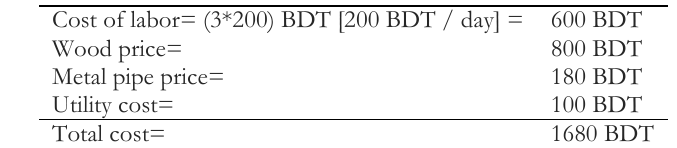
Table 7. Cost estimation for the prototype is given